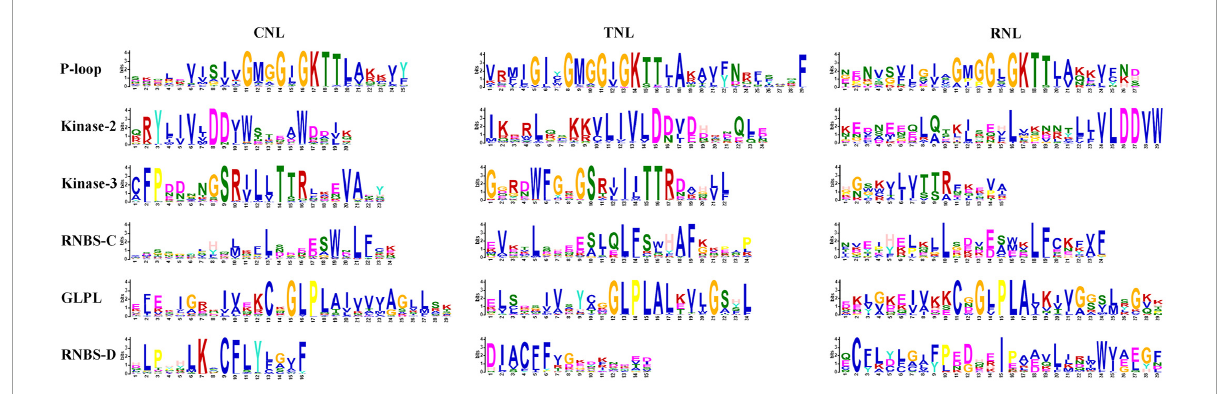
FIGURE1 Six conserved motifs in the nucleotide-binding site (NBS) domain of the four Ipomoea species. The amino acids (aa) of the six conserved motifs are extracted. Larger letters indicate higher frequency.